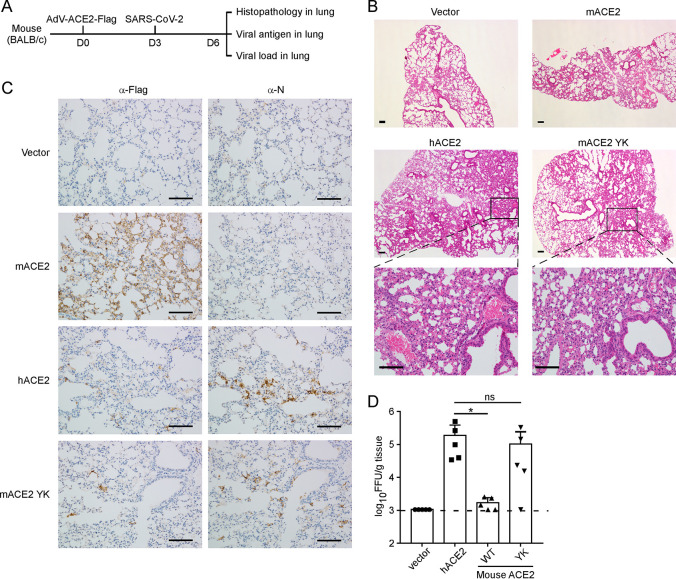
The humanized mouse ACE2 mediate viral entry in vivo.(A) Schematic representation of the experiment timeline; (B-D) The wild-type mice were transduced by recombinant adenovirus expressing ACE2 variants for 3 days, followed by SARS-CoV-2 challenge. Mice were sacrificed at day 3 post infection (n = 5 mice per group) and lung tissues were collected for H&E staining (B), immunostaining (C), and viral load titration (D). The ACE2 and viral N antigen expression were detected with anti-FLAG and anti-N serum, respectively. Representative images are shown from n = 5 mice. Scale bar, 100μm (B and C). Viral load was determined by focus-forming assay. ns, no significance; *, P < 0.05. Significance assessed by one-way ANOVA (D).